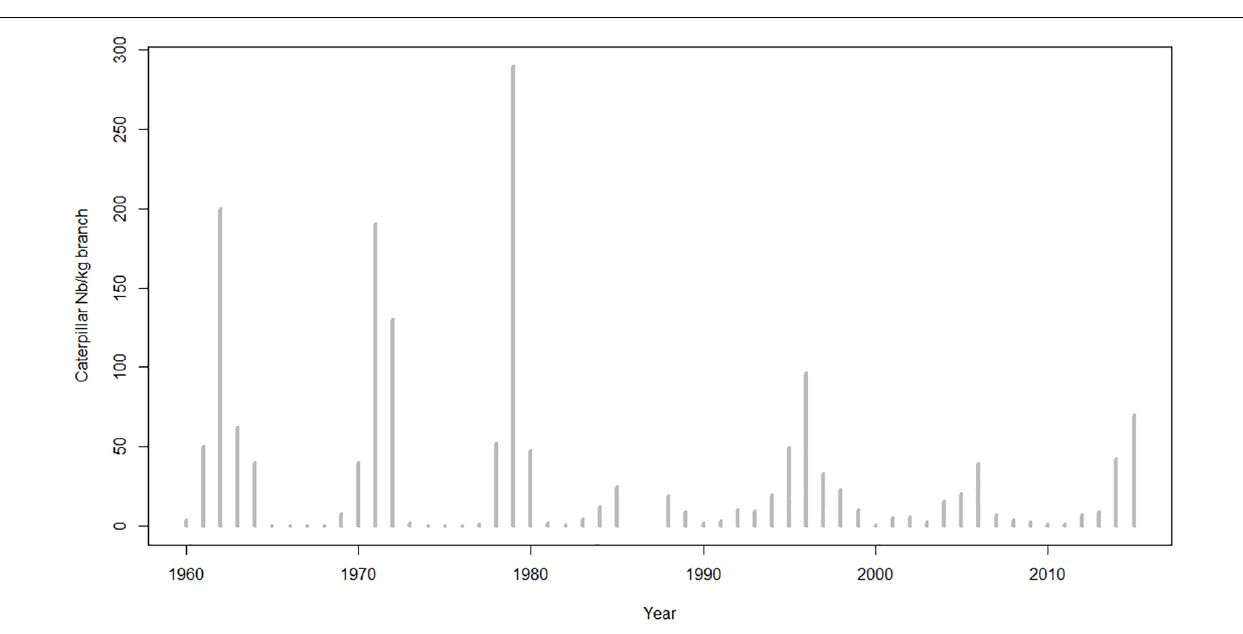
FIGURE 3 | The Les Combes LBM outbreaks time-series from 1960 to 2015 (direct